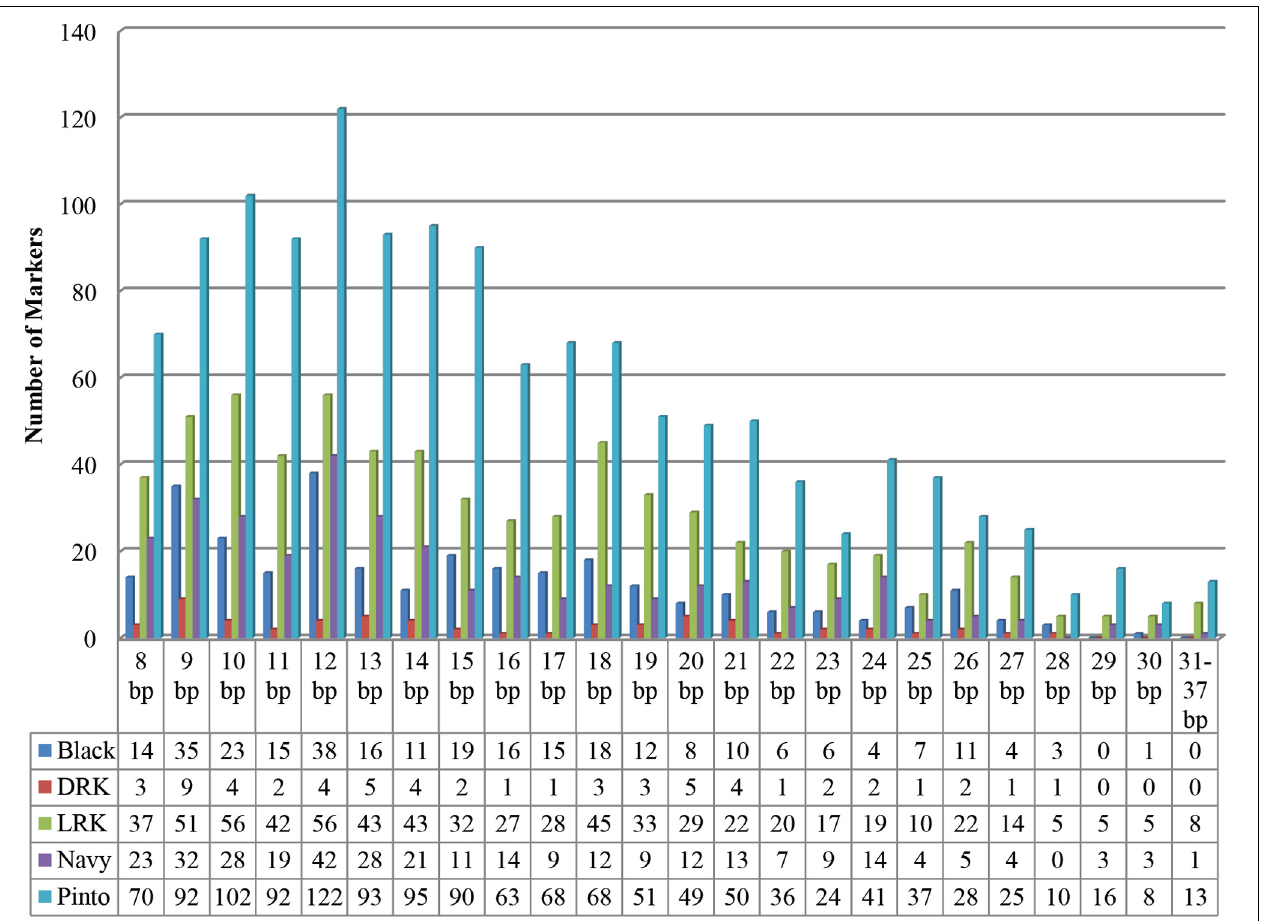
FIGURE 1 | Distribution of 2687 InDle sizes in five market